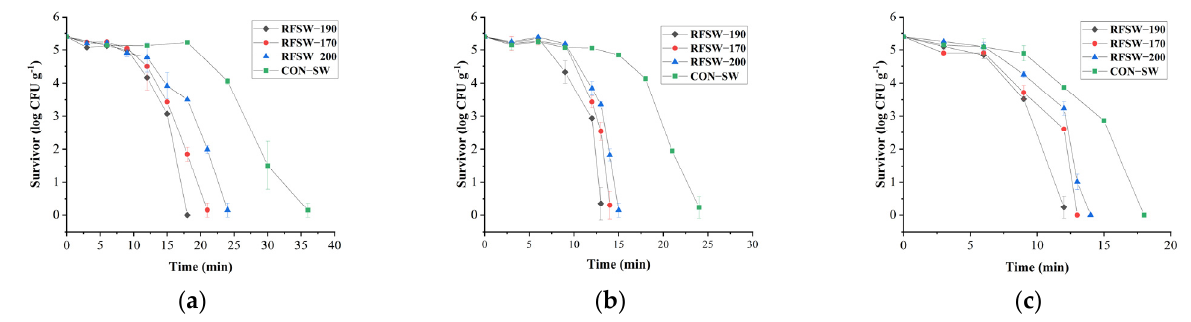
Figure 6. Log survivor of G. stearothermophilus spores in PSPS under the different electrode gaps and SW temperatures of 116 °C ( a ), 121 °C ( b ), and 124 °C ( c ). From the comparison and detailed analysis of the time–temperature profile and G.